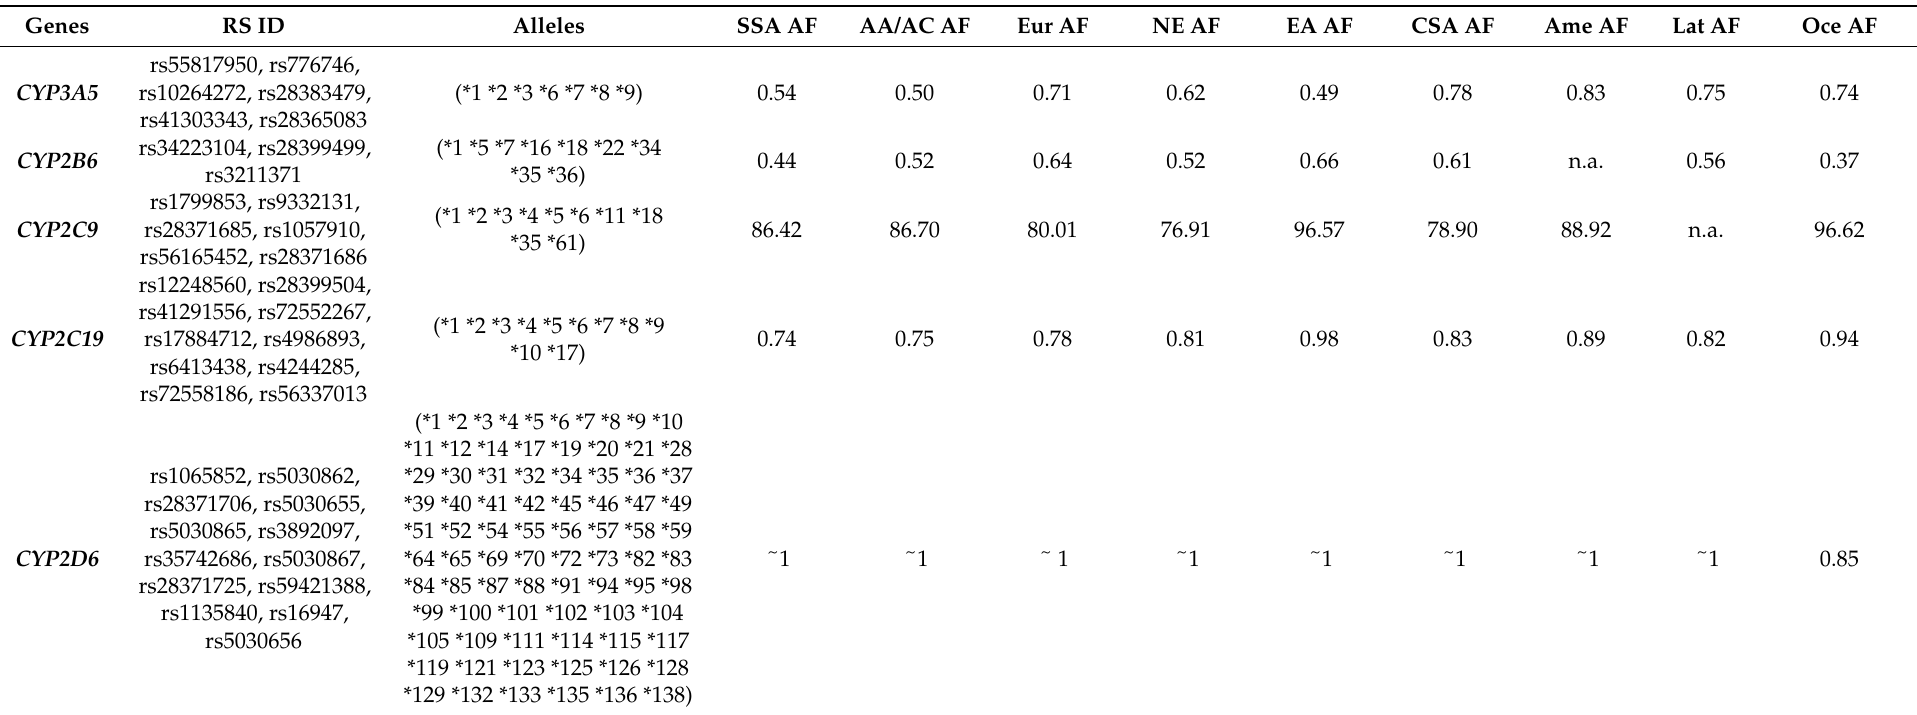
Table 3. Selected SNPs. Frequency of detectable alleles have been calculated according to population data [5]. Abbr.: SSA = Sub-Saharan African; AA/AC = African American/Afro- Carribbean; Eur = European; NE = Near Eastern; EA = East Asian; CSA = Central/South Asian; Ame = American; Lat = Latino; Oce = Oceanian; AF = allele frequency.